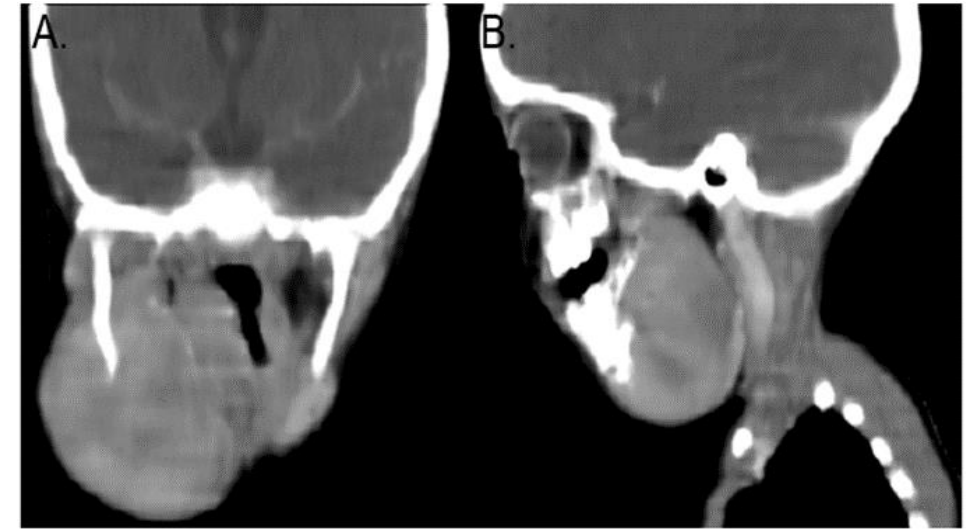
Fig. 2. CT scan of the head showed an isodense mass on the right mandible.